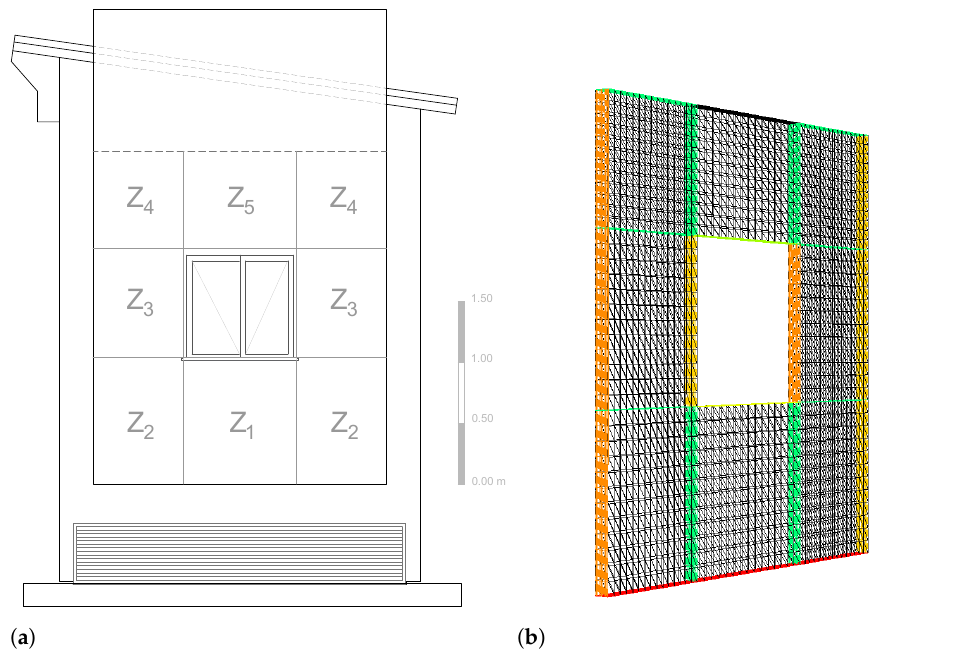
Figure 7. ( a ) Considered zones of the OVF; ( b ) tetrahedral mesh of the air chamber zones with the window opening.